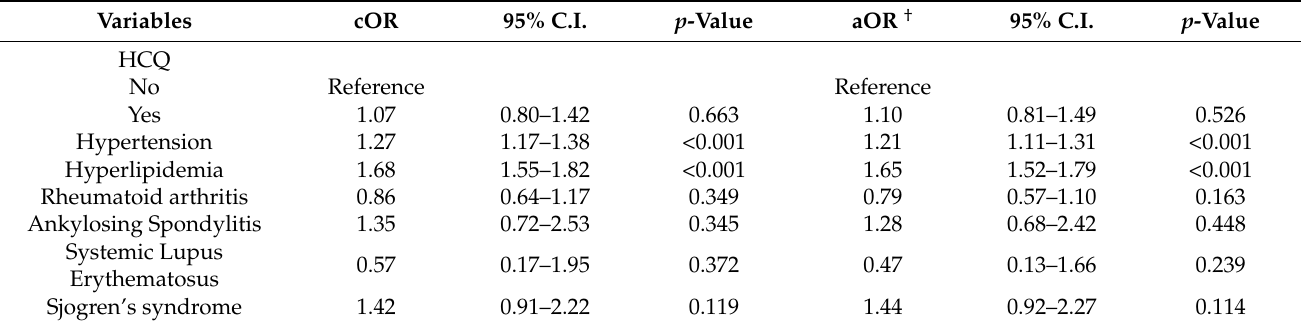
Table 2. Conditional logistic regression of risk of ophthalmic